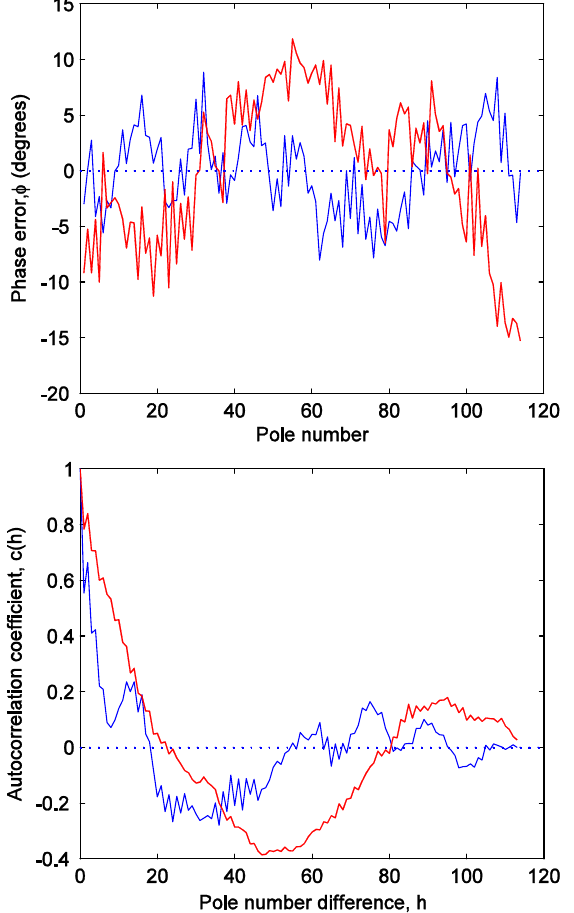
FIG. 7. Phase error differences (upper) and autocorrelation coefficients (lower) for the APS low (blue) and high (red) phase error